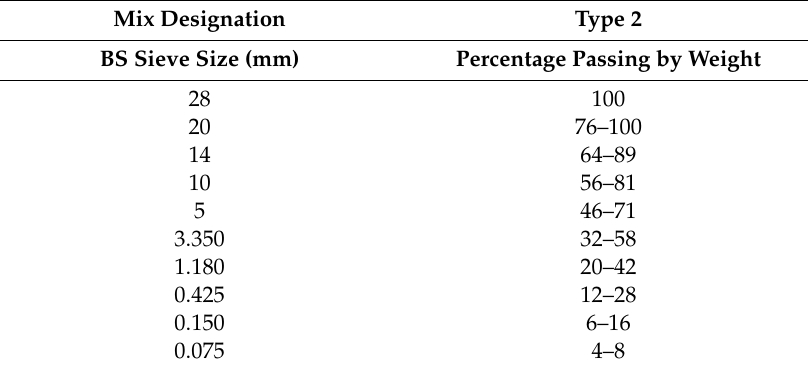
Table 1. Aggregate for blended mix by JKR.